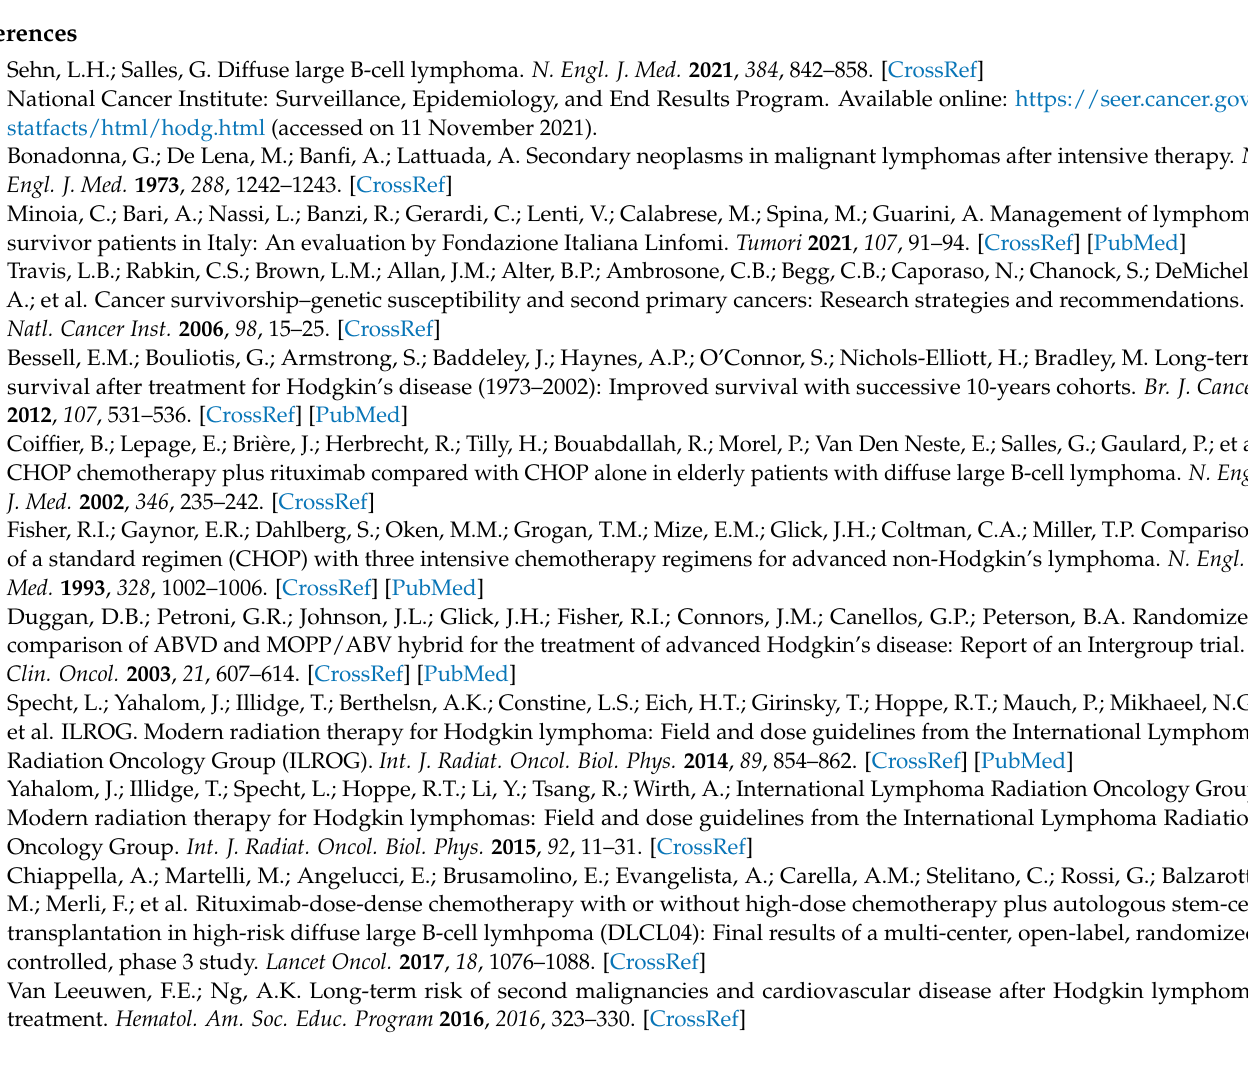
Table S2: Risk of